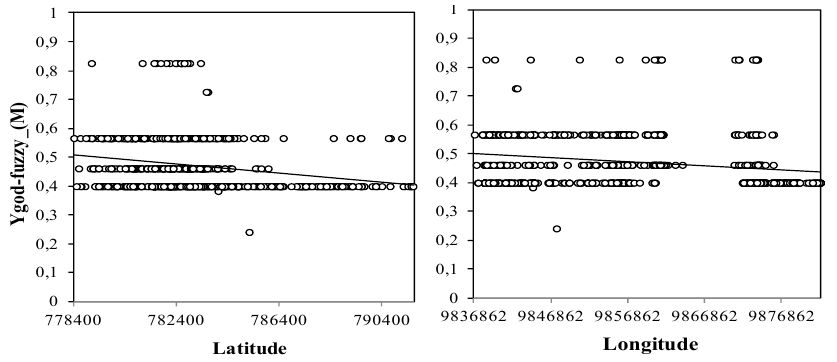
Figure B1. Preliminary drift analysis for the spatial domain. Figure A1. Preliminary drift analysis for the spatial domain.